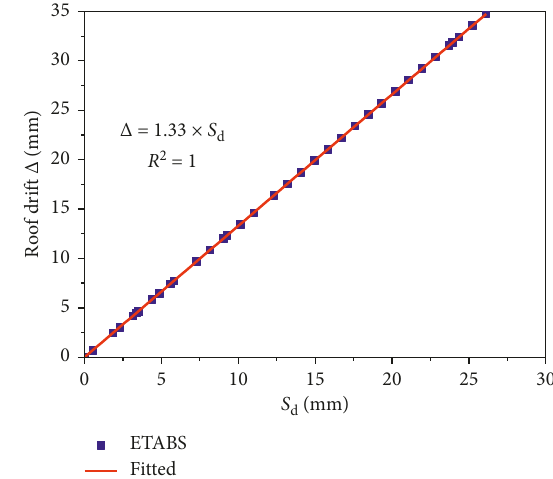
Figure 33: Relationship of the roof drift and S